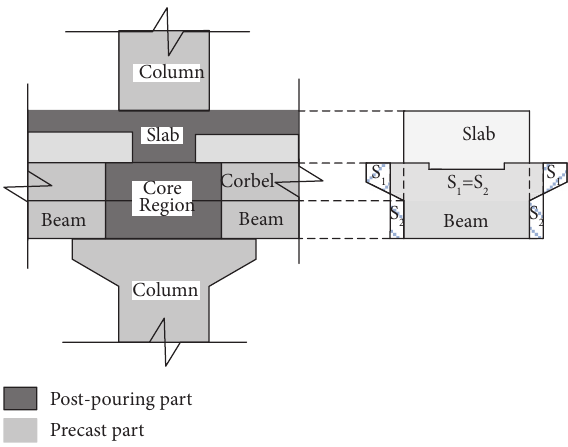
Figure 12: Simplified model of core region of assembled